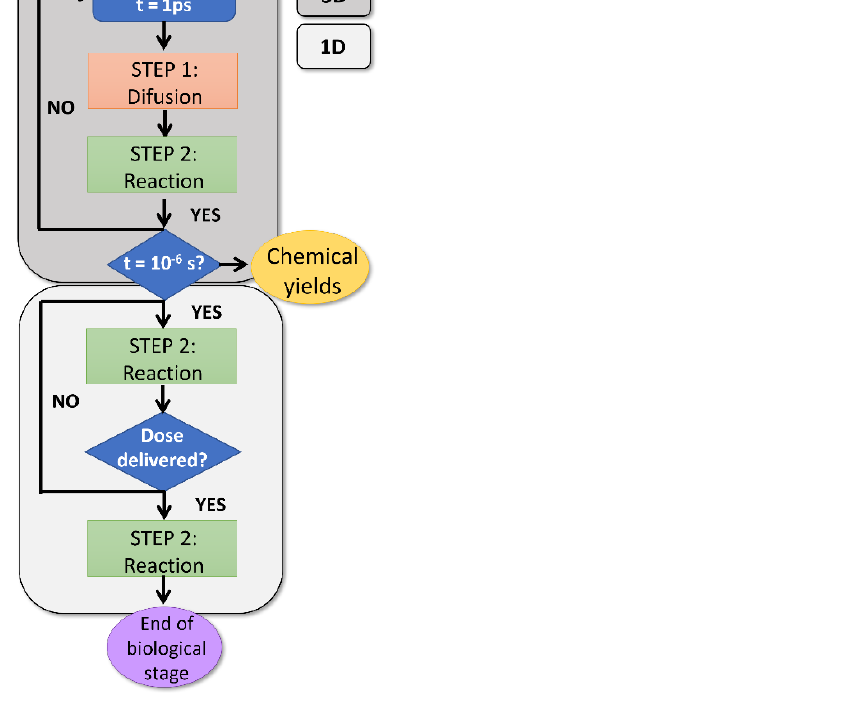
Figure 9. Workflow used for the simulation of the chemical and biological stages of the